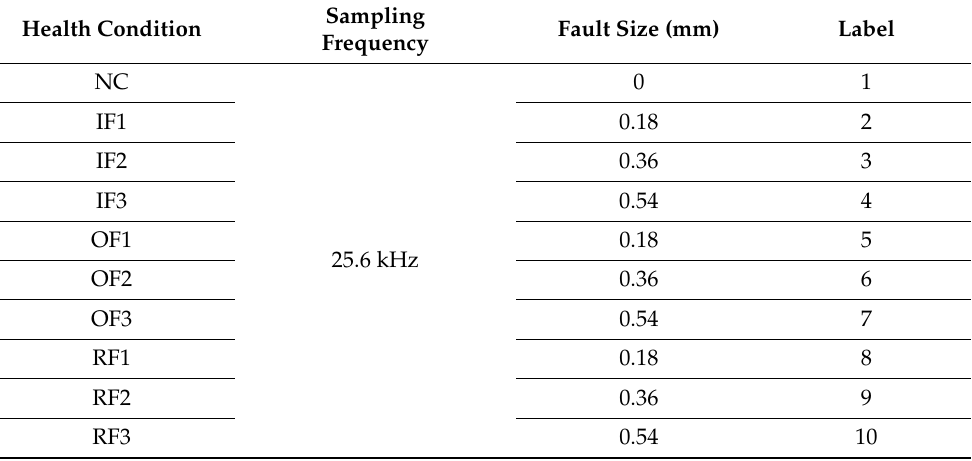
Figure 8. Structure display of rolling bearing. Table 3. The description of the datasets.